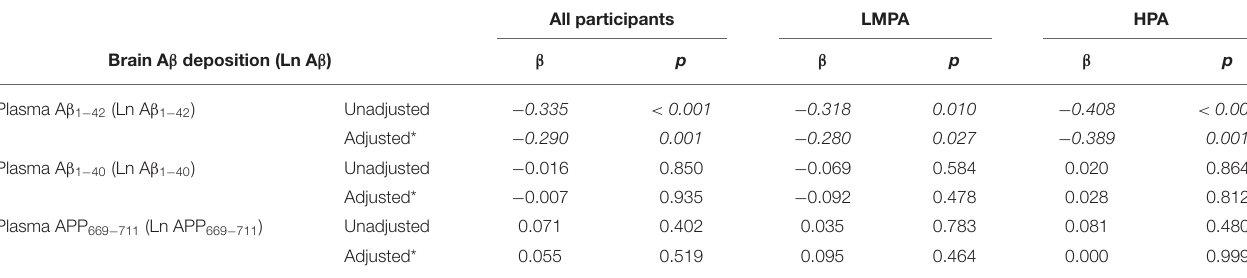
TABLE 5 | Correlation of brain amyloid load with blood biomarkers levels in the all-study participants and after stratification by PA levels. All participants LMPA HPA Brain A β deposition (Ln A β